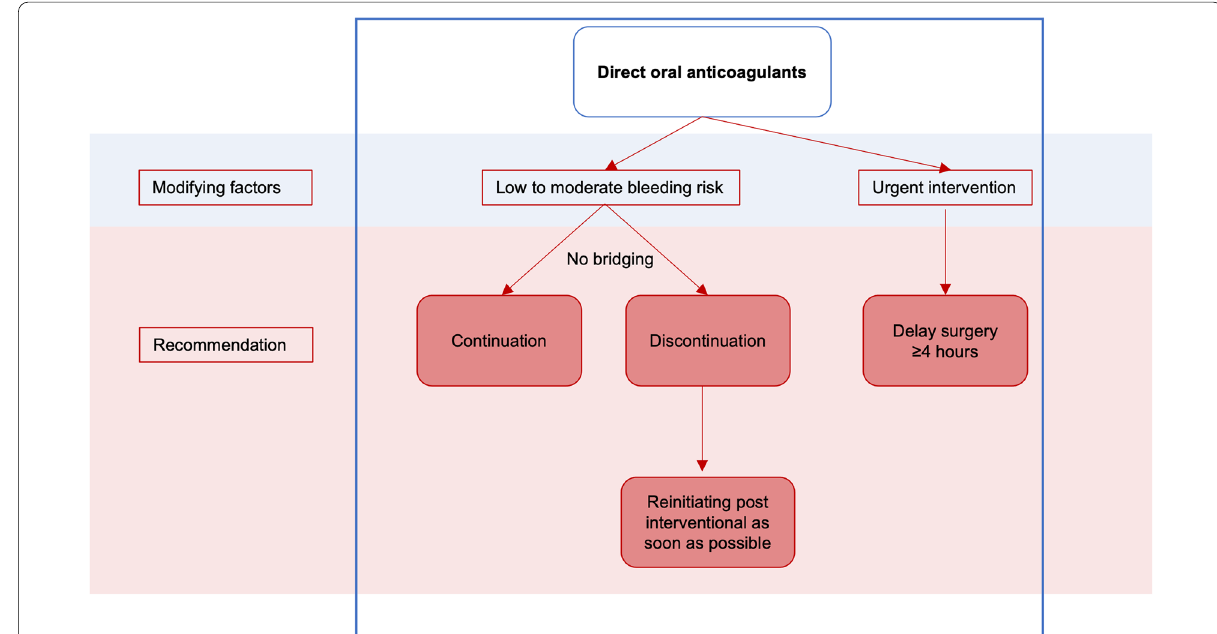
Fig. 6 Clinical recommendations for oral surgery in patients treated with direct oral anticoagulants